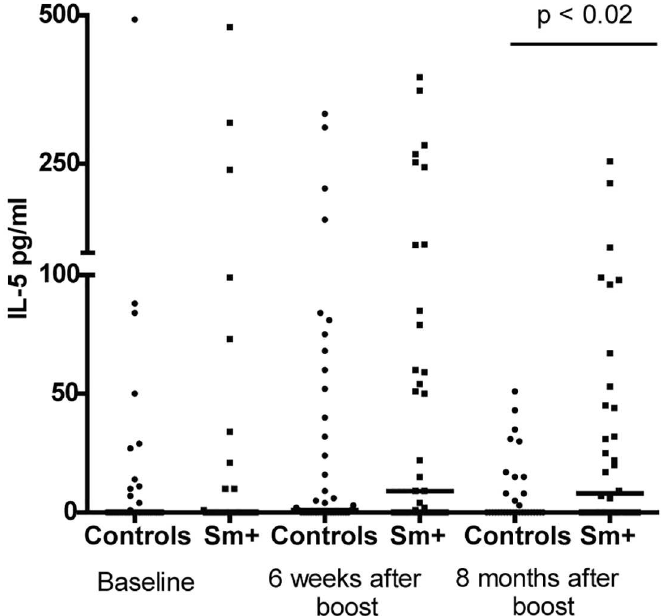
Fig 4. Individuals with schistosomiasis at the time of vaccination produced more IL-5 in response to in vitro tetanus toxoid stimulation compared to uninfected controls after vaccination. Whole blood cultures were stimulated in vitro with tetanus toxoid antigenfor 72 hours and IL-5 was measuredin the resulting supernatantfluids by ELISA at baseline, 6 weeks after boost and 8 months after boost. Circles representstudy controls, individuals at baselinenegative for S . mansoni and Soil Transmitted Helminths, and squaresrepresent those schistosomiasis positive at baseline.Bars represent median IL-5 levels at each time point and statistical differences at each time point were determinedusing the Mann-Whitney test with a p < 0.05 considered